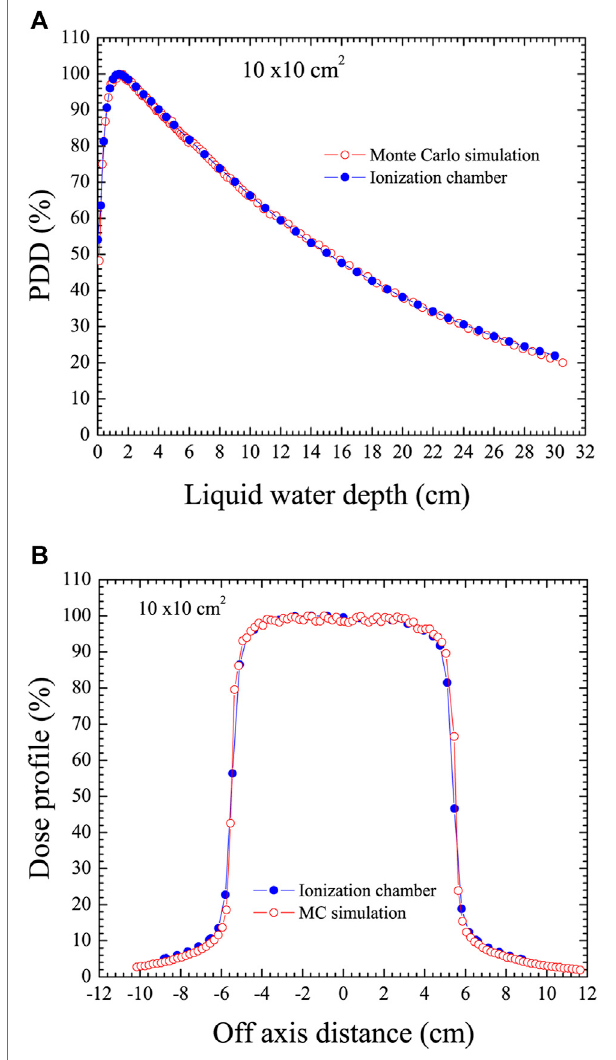
FIGURE 1 | (A) PDD calculated by MC simulation compared to that measuredwithaPTW 30013 ionization chamber forthe 10 × 10 cm 2 fi eld. (B) Dose pro fi le calculated by MC simulation compared to that measured with a PTW 30013 ionization chamber for the 10 × 10 cm 2 fi